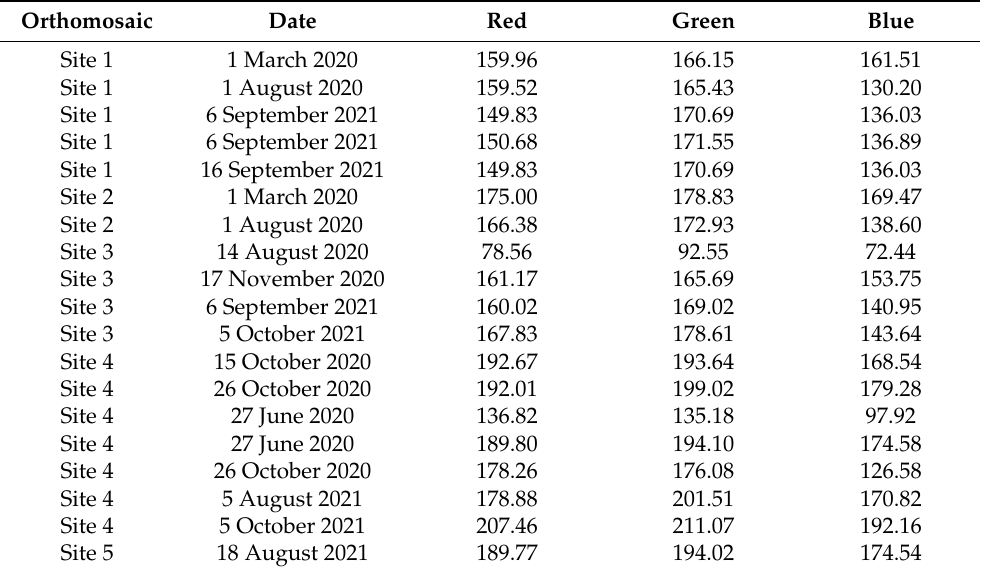
Table 1. Orthomosaics used in this study, with the date of image collection and their mean RGB-values.